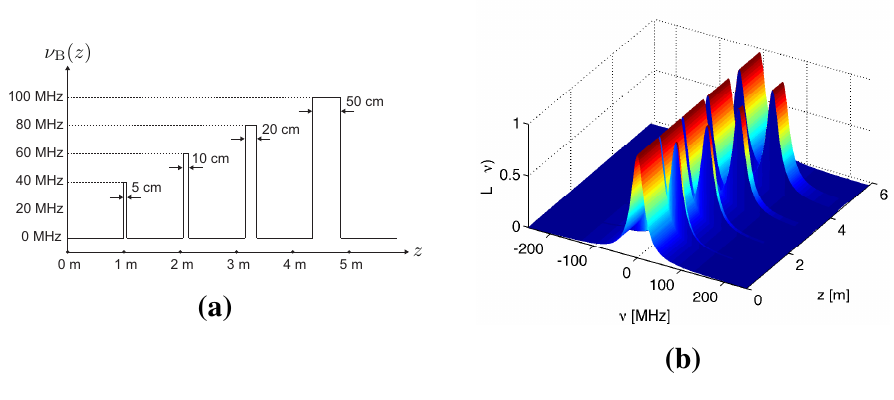
Figure 10. Simulation condition: ( a ) assumed Brillouin frequency shift (BFS) and ( b ) the Lorentzian spectrum.